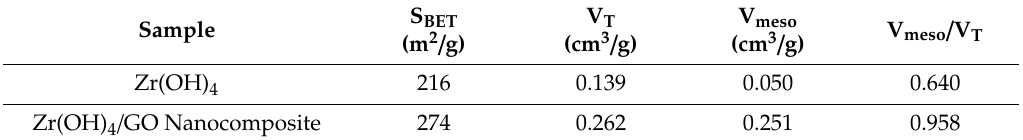
Table1. CharacteristicsoftheporousstructureofandZr(OH) 4 / GOnanocompositeandpristineZr(OH) 4 Table 1. Characteristics of the porous structure of and Zr(OH) 4 /GO nanocomposite and pristine Zr(OH) 4 .